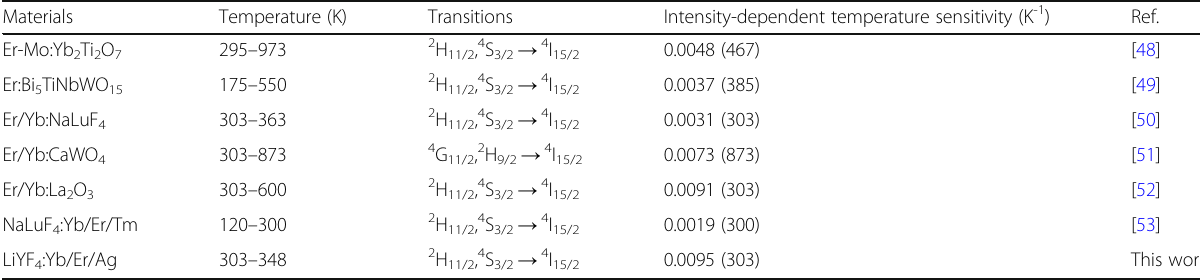
Table 1 The sensitivity values of optical temperature sensors in different host materials Materials Temperature (K) Transitions Intensity-dependent temperature sensitivity (K -1